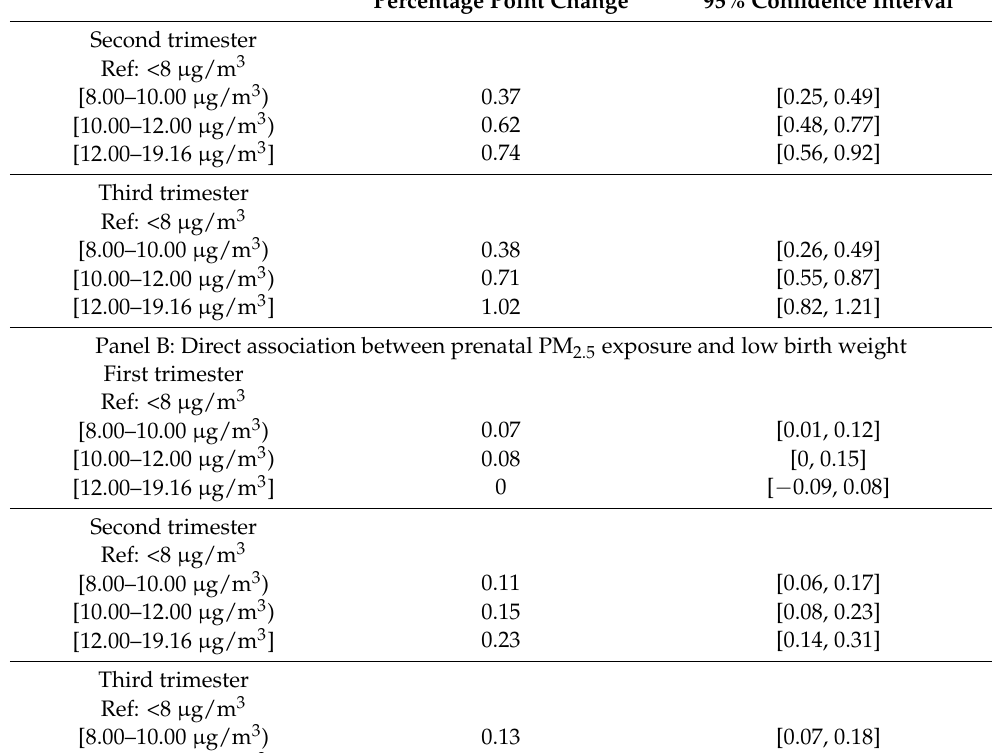
Panel C: Direct association between preterm birth and low birth weight Preterm birth Panel D: Direct association of prenatal and post-birth PM 2.5 exposure with infant death Prenatal exposure